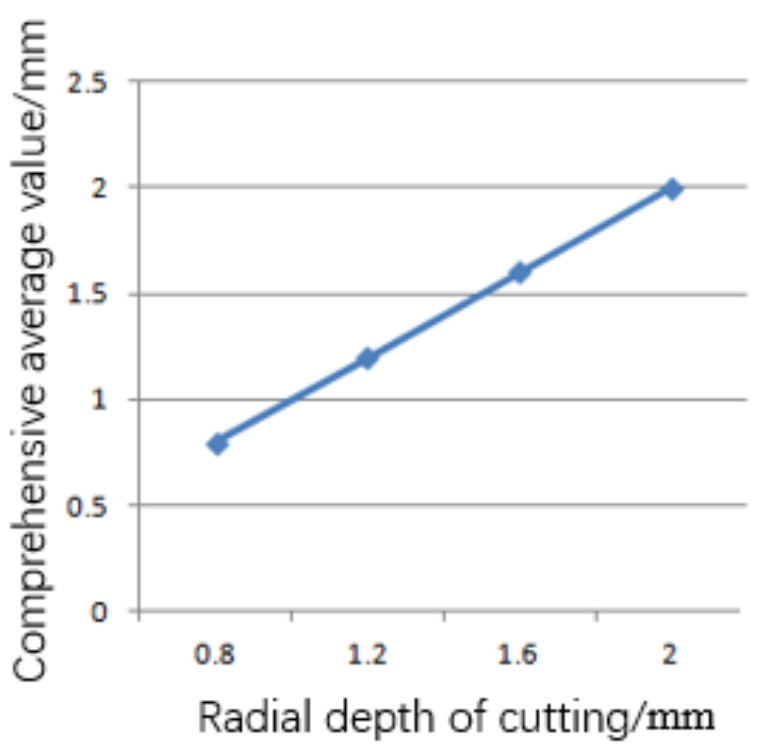
Figure 9. Influence on deformation of different radial cutting depths.